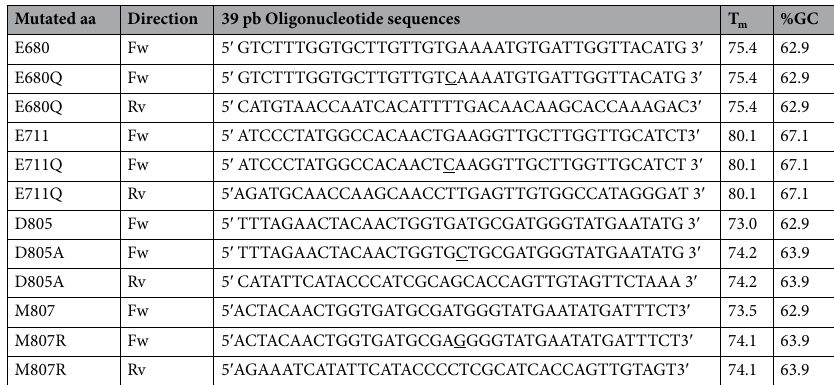
Table 3. Oligonucleotides designed to obtain the following point mutants: E680Q, E711Q, D805A, M807R and E680Q-M807R. T m : melting temperature; %GC: Guanine and Cytosine